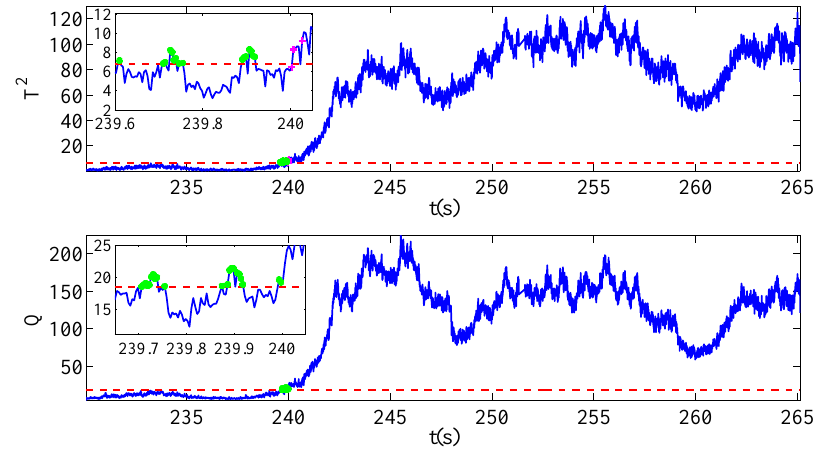
Figure 4. Fault detection results for f 1